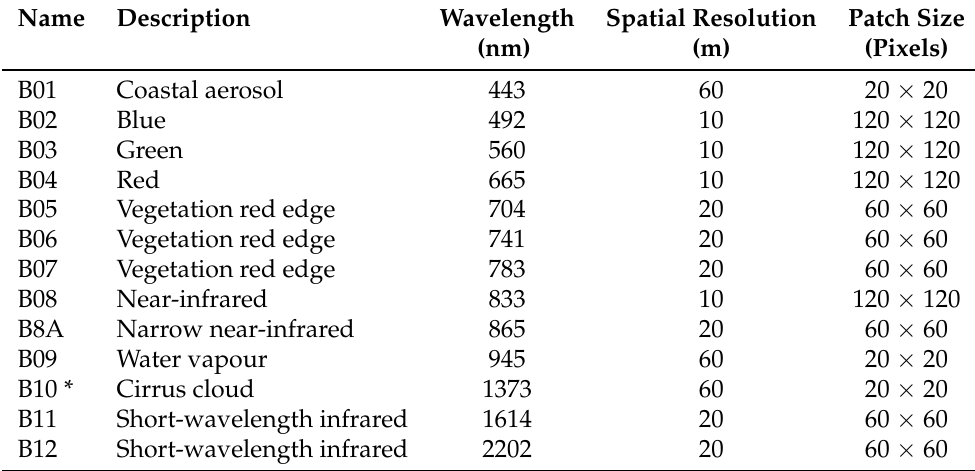
Table 2. Multispectral band name, description, wavelength (nm), spatial resolution (m) and patch size (pixels) of the BigEarthNet with Sentinel-2 database. (*) The spectral band B10 was discarded as it does not contain information of the surface because of the sen2cor processing methodology.